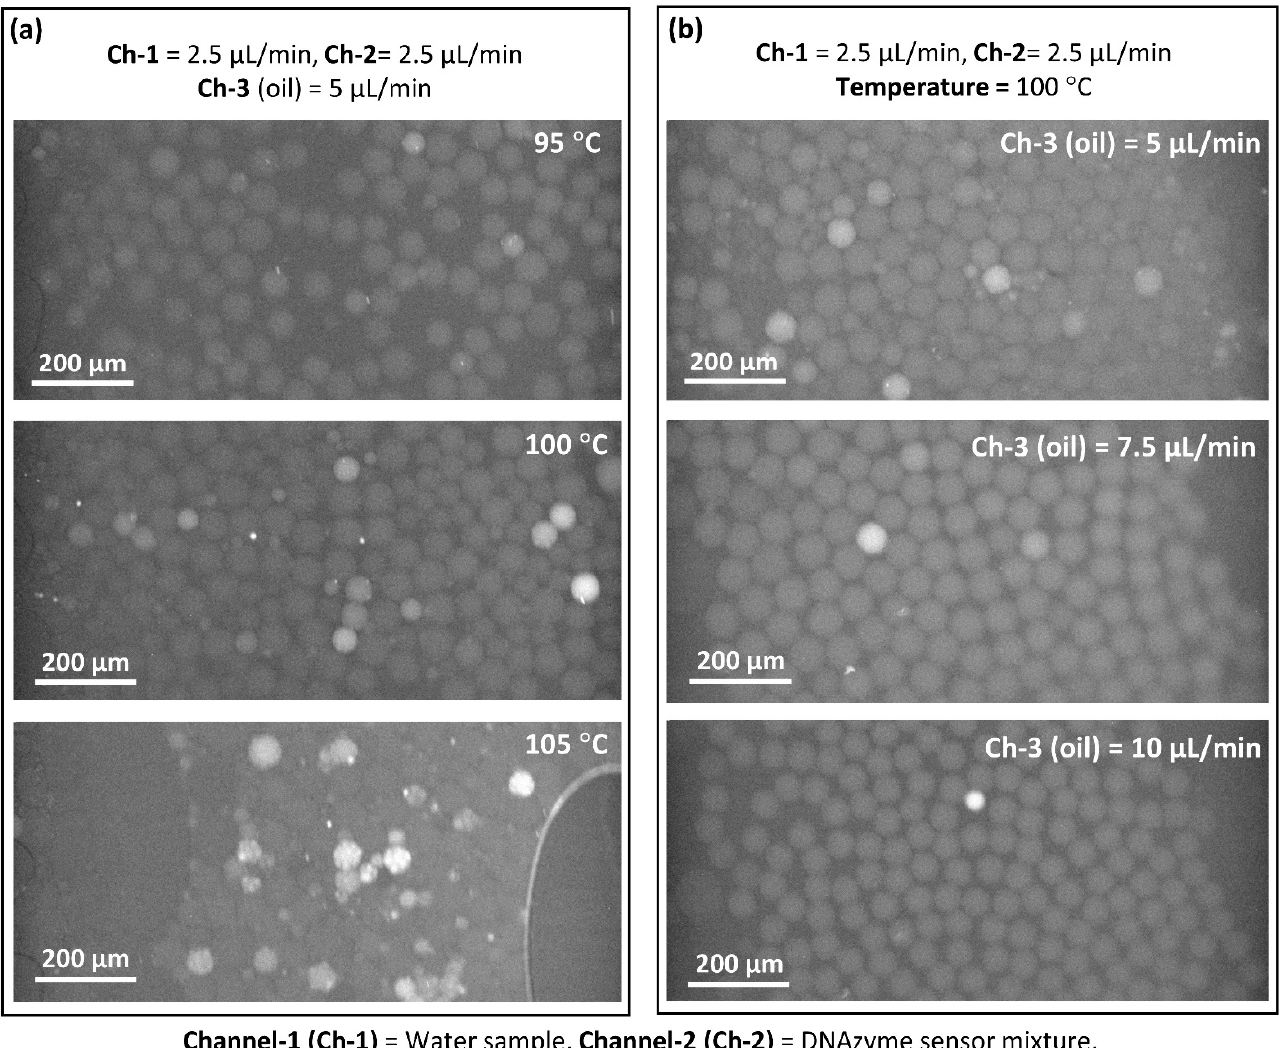
Figure 3. ( a ) Heat treatment of the water droplets at different temperatures to lyse the bacteria encapsulated inside the droplets. ( b ) Optimization of the flow rate of the oil phase while maintaining the aqueous medium flow rates constant. The approximate concentration of E. coli (number of E. coli /mL) used was ≅ 8 × 10 7 /mL.